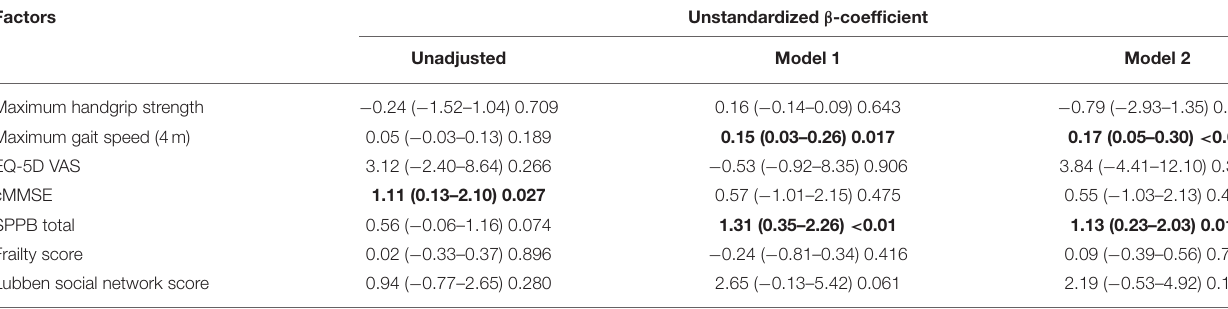
TABLE 2 | Intervention effect on change in cognition, physical performance, and overall health rating.